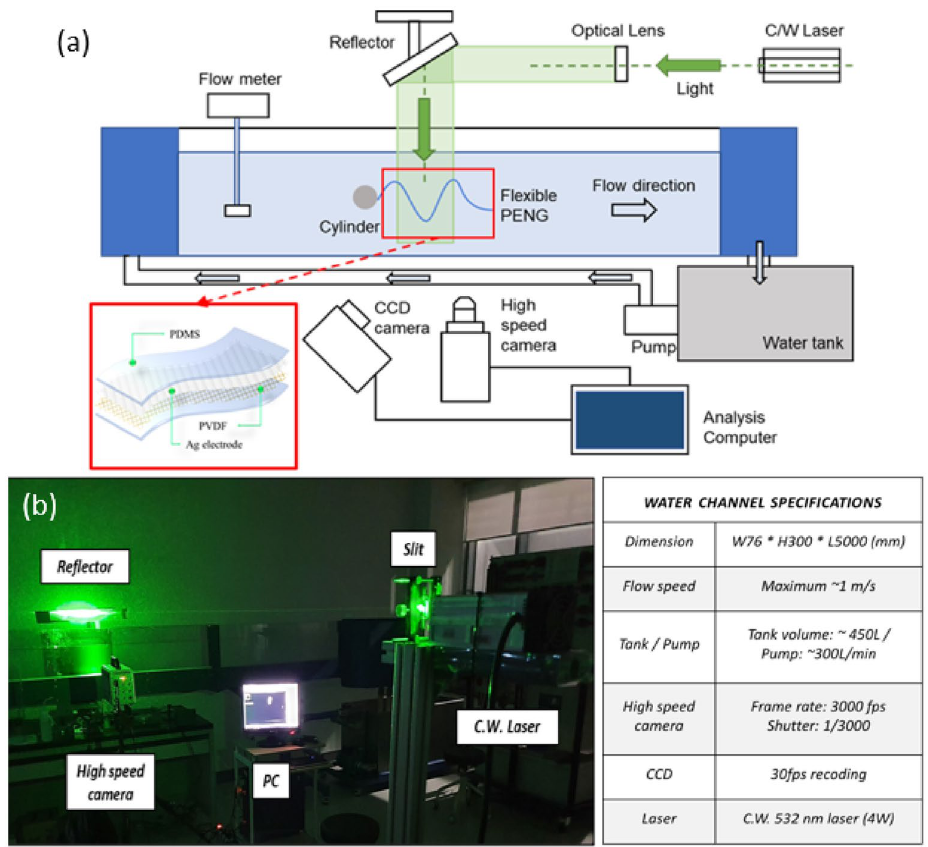
Figure 1. ( a ) Schematic of the water channel system configuration. ( b ) Actual operation image and